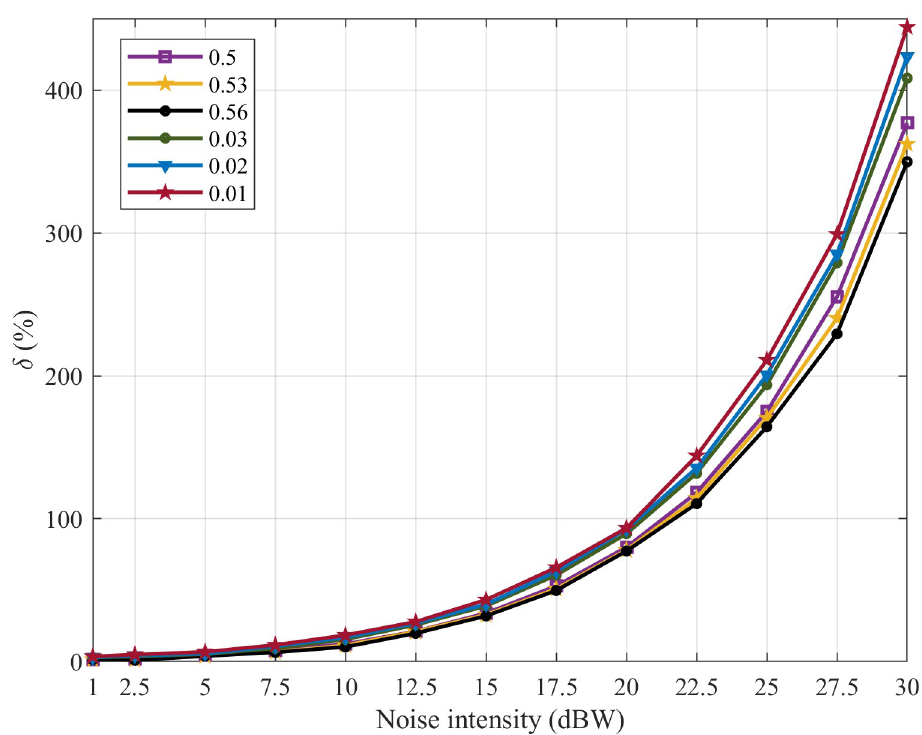
Fig 10. The change of the δ of the three SFSNNs with the high ACC and the three SFSNNs with the low ACC.